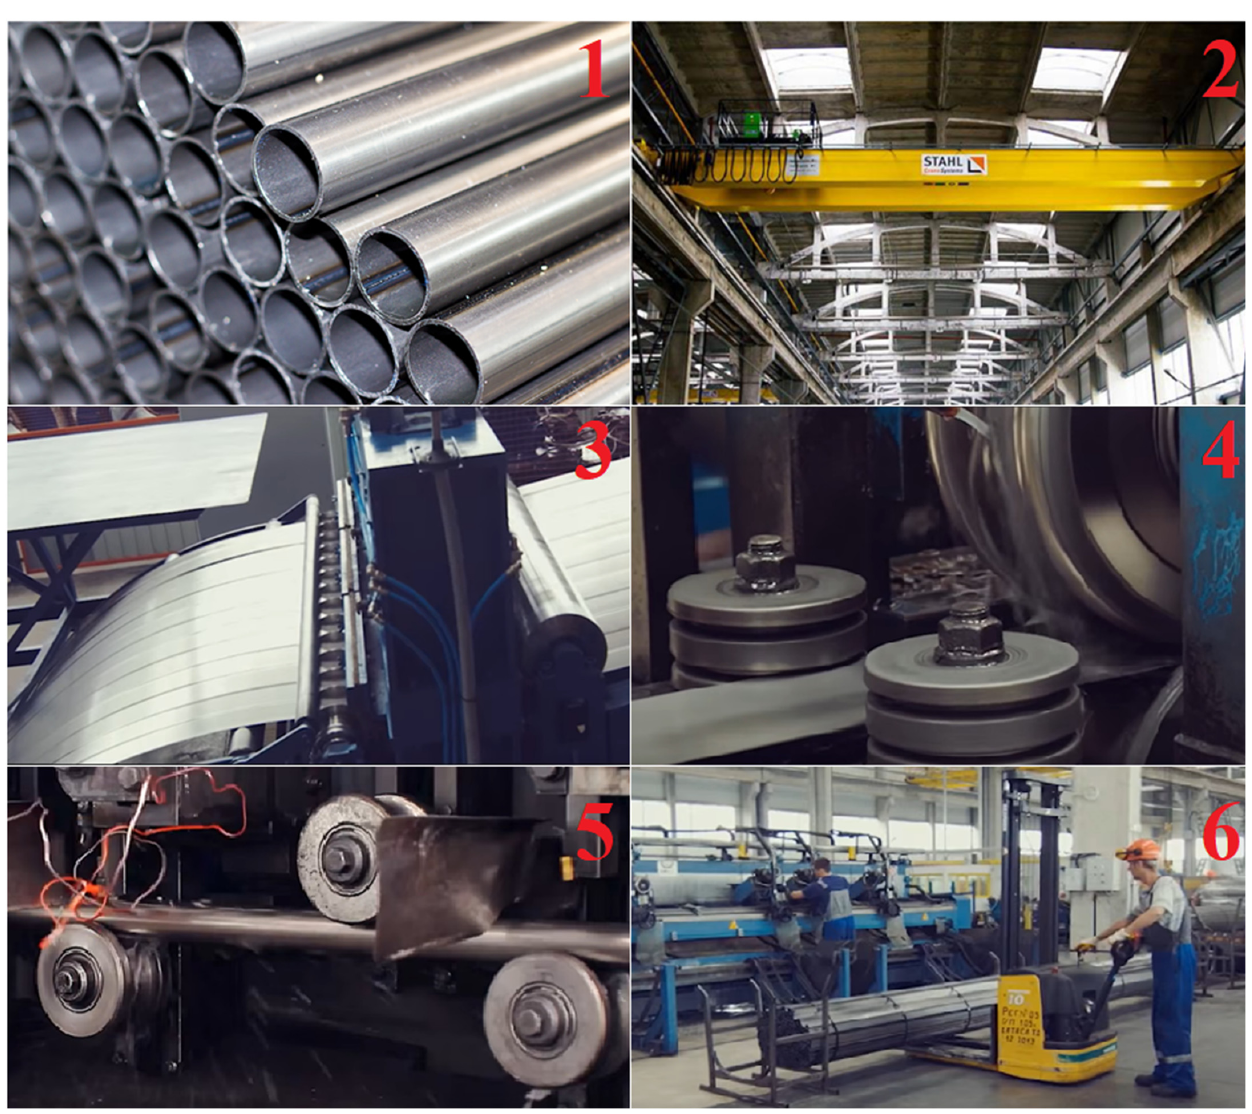
Figure 3. Illustration of the basic stages of the production process, view of the crane with which the production hall is equipped, and an example of final products manufactured in the plant (1—manufactured products (steel pipes for upholstered furniture); 2—production hall equipped with overhead cranes; 3—cutting steel rolls on line for longitudinal cutting; 4—forming a blank before starting the welding operation on the bending and electric welding line; 5—the next stage of pipe production—removing the metal allowance from the pipe; 6—section for packing pipes and transporting them later with a forklift truck).